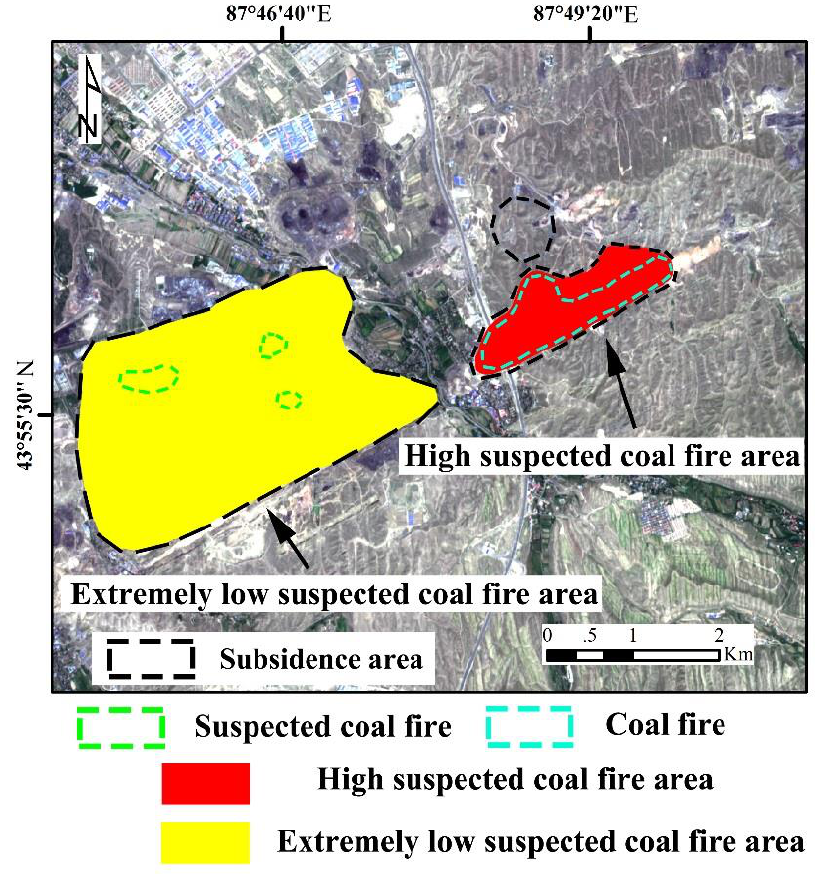
Figure 9. Final coal fire areas in the study region.